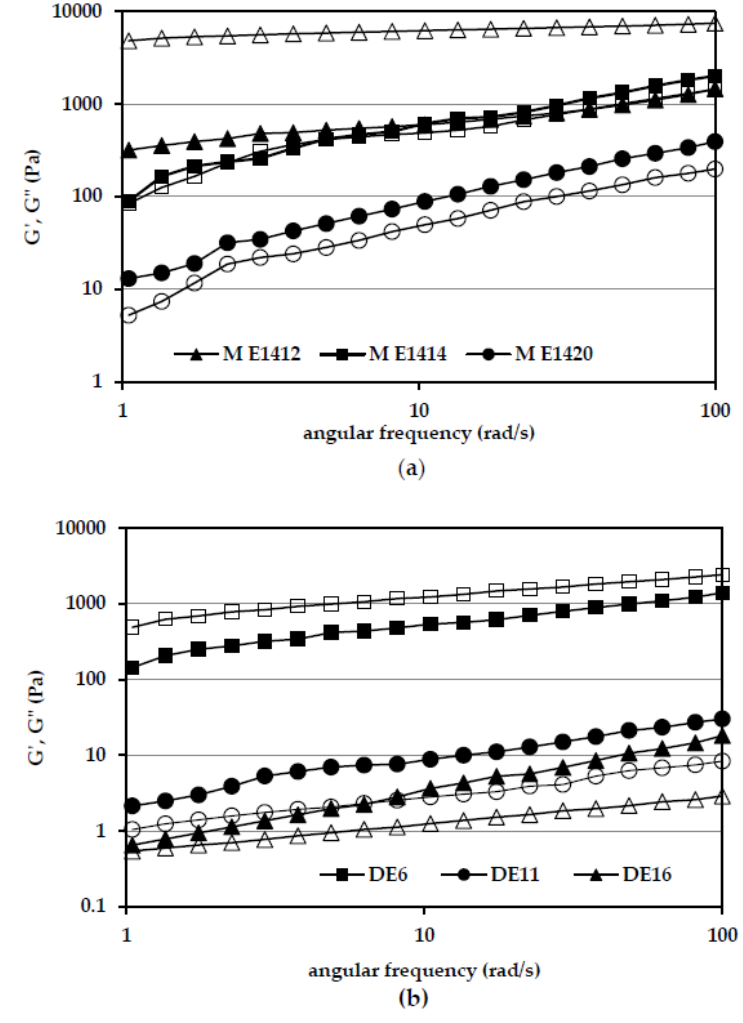
Figure 3. Mechanical spectra of emulsions with addition of 50% solutions of selected DE 6 maltodextrins ( a ), and with addition of 50% solution of DE 6 – 16 M E1422 (b). G ’— empty markers, G ”— filled markers.